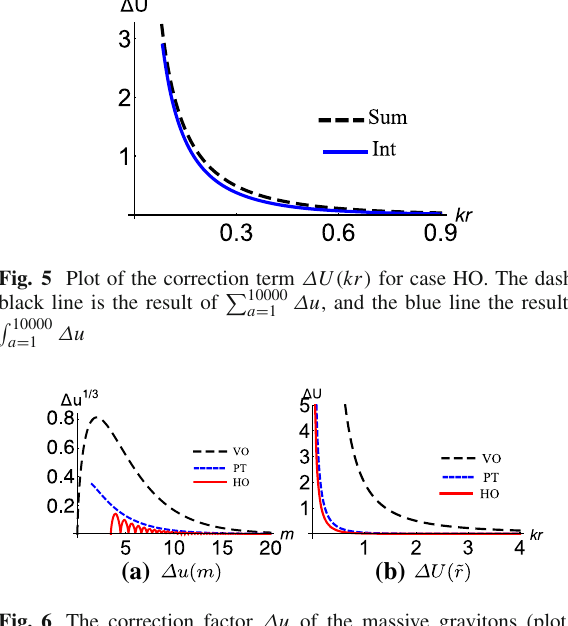
Fig. 6 The correction factor Δ u of the massive gravitons (plot as Δ u 1 / 3 )andtherelativecorrection Δ U forthethreecases.Theparameter kr in (a) is set as kr =